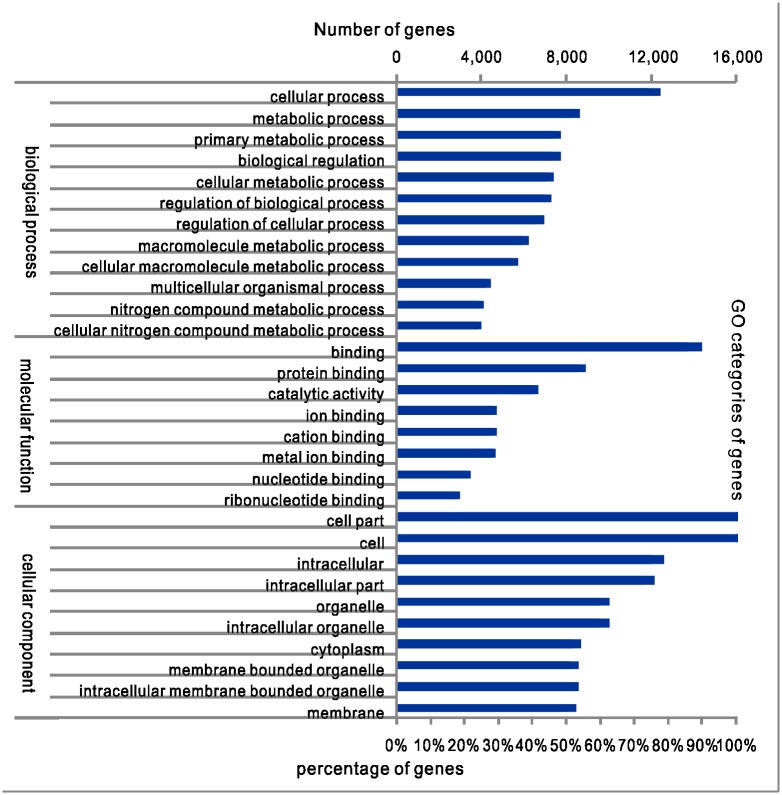
The top 30 most abundant GO sub-categories.